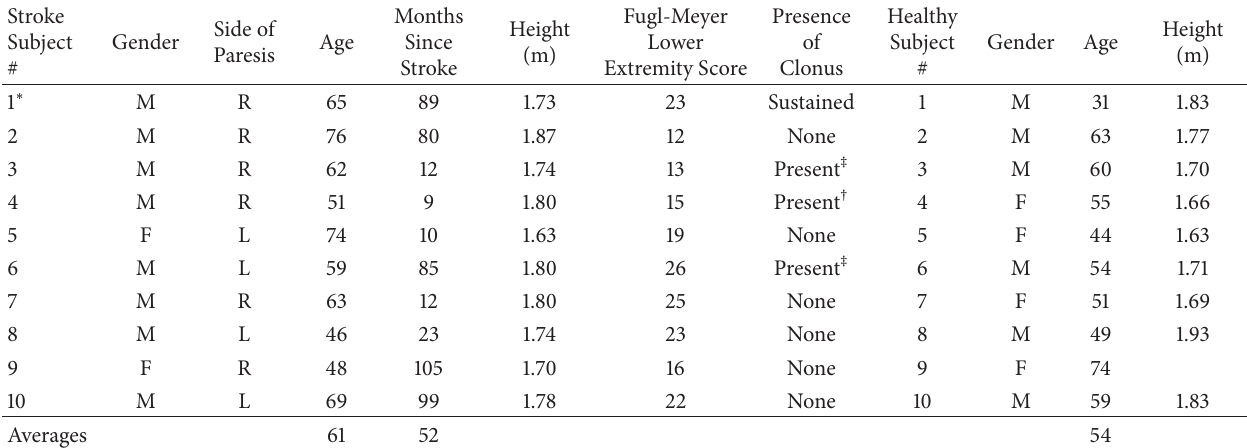
Figure 1: Longitudinal ultrasound image of the lateral gastrocnemius muscle. Top solid yellow line marks the superficial aponeurosis and the deep solid yellow line marks the deep aponeurosis. 𝐿 𝑓 follows the fascicle length from deep to superficial aponeuroses, and 𝜃 is the angle between Lf and deep aponeurosis. Table 1: Demographics for 10 post-stroke and 10 healthy